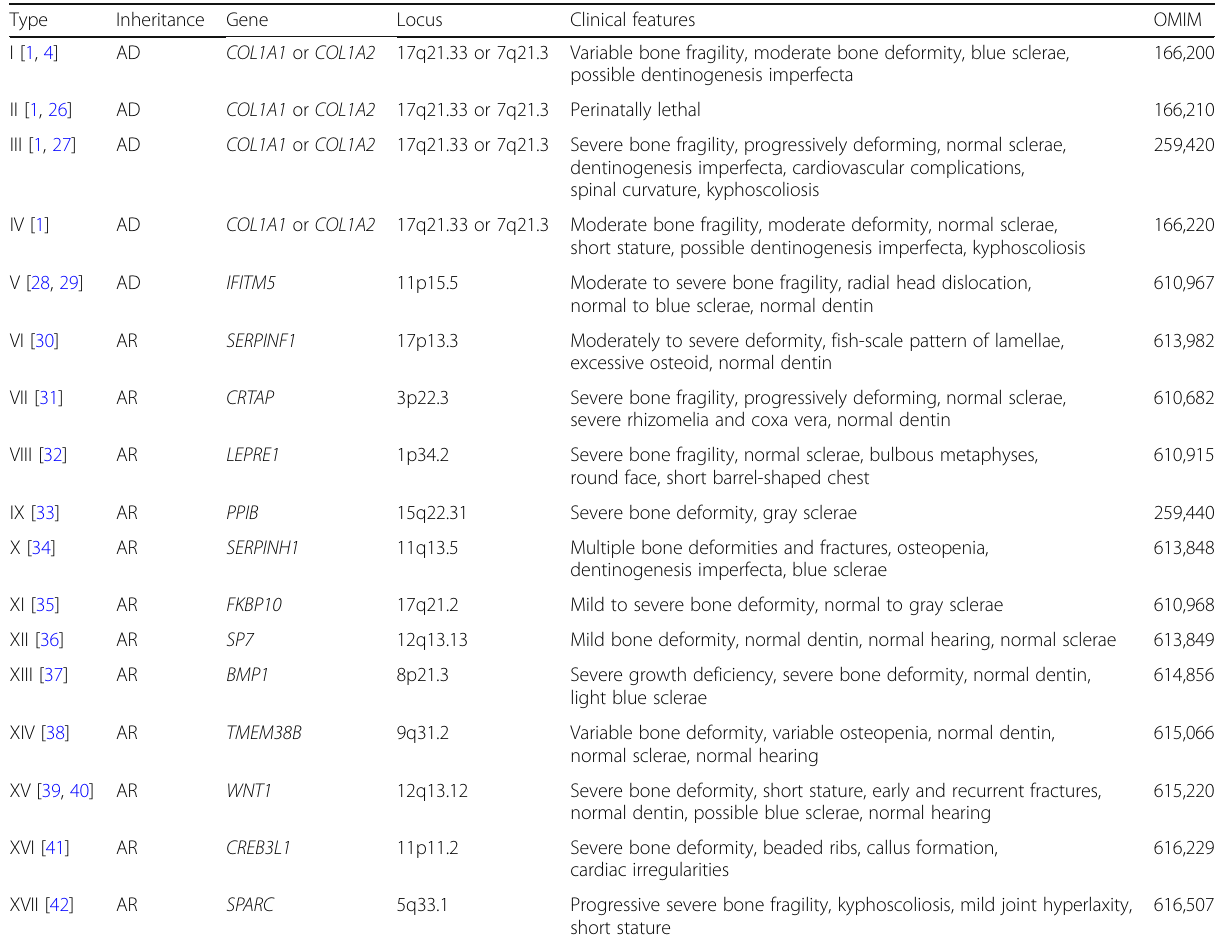
Table 1 Osteogenesis imperfecta classifications